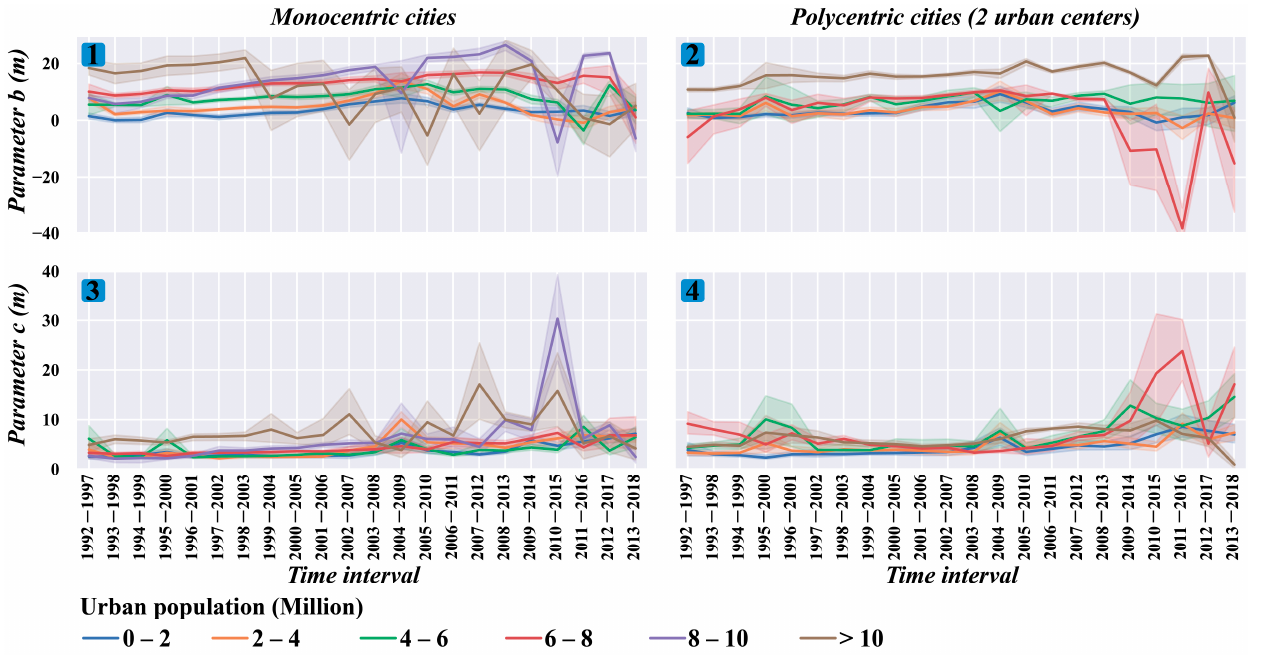
Figure 10. Parameters of Gaussian models fitted for spatiotemporal variations in intensity of urban- related human activities observed in the 234 sample cities between 1992 and 2018, with lower limit of DN values set to 30 and interval of time set to 5 years.